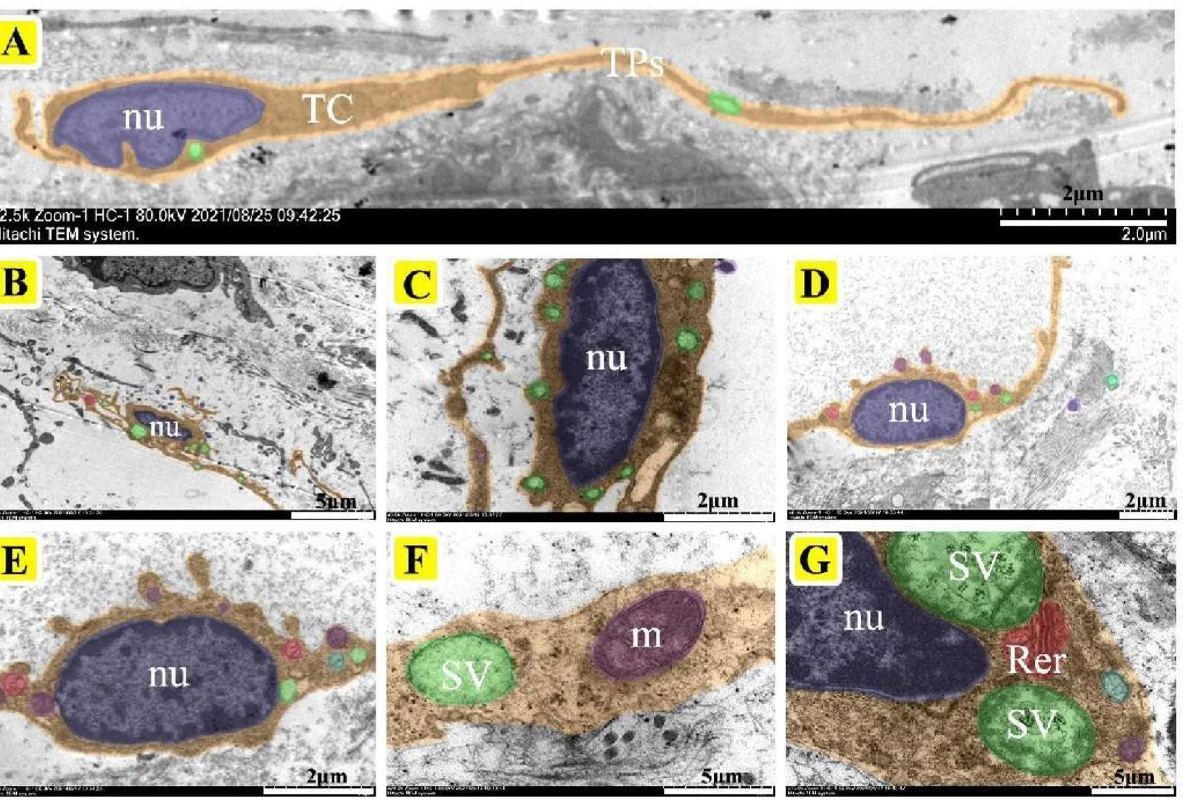
Figure 2. The localization of telocytes in the corpus epididymis of yak by TEM. ( A ) The slender TPs were similar to the TCs of the caput epididymis, which alternated between thick processes and slender podomers. Secretory vesicles and mitochondria were distributed around the TPs (Scale bar = 5 µm). ( B , C ) Telocytes are distributed in the interstitium of the corpus, with a large body and slender TPs (Scale bar = 2 µm). ( D , E ) The TCs are clearly visible in the interstitium of the corpus with ellipsoidal nuclei and slender TPs. A large number of secretory vesicles were distributed throughout the cells (Scale bar = 5 µm). ( F ) The secretory vesicles and mitochondria in TPs under high magnification. ( G ) The nucleoli of TCs were clearly visible under high magnification and were rich in extranuclear secretory vesicles and rough endoplasmic reticulum (Scale bar = 5 µm). nu: nucleus, SV: secretory vesicles, m: mitochondria, Rer: rough endoplasmic